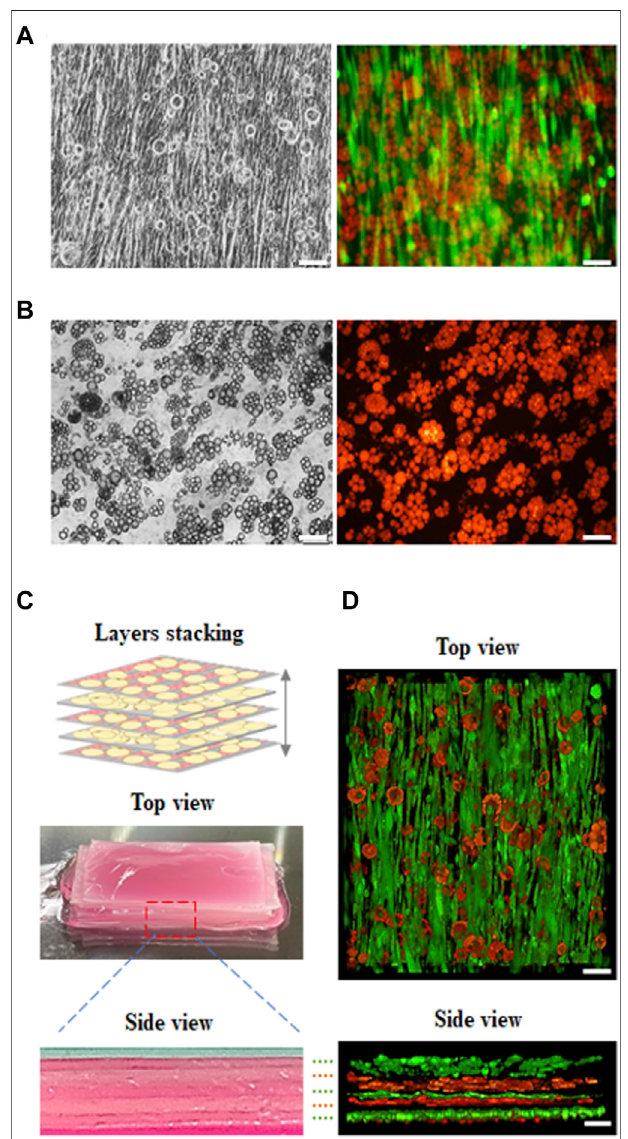
FIGURE 6 | Fluorescence images of developed cultured meat. The cultured meat containing fat was synthesized with a (A) muscle-like layer topped with adipocytes, with myosin (green) and lipid droplets (red); (B) adipose-like layer with lipid droplet (red). (C) The previous two layers (a, b) were made by alternately stacking them to develop cultured meat containing fat as shown in the digital camera images (top and side view). (D) The 3D view in z-stack reconstruction (top and side view) of cultured meat containing fat (scale bar = 100 μ m).